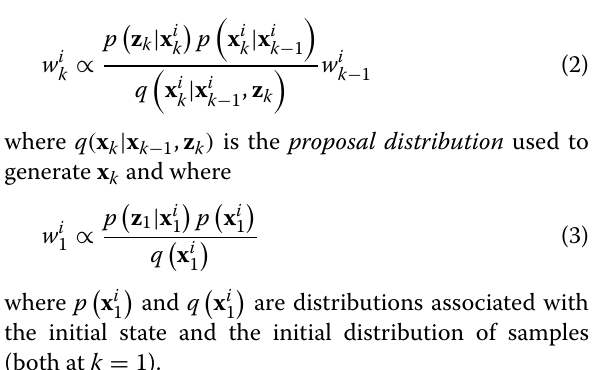
Algorithm 1 SIR Filter—Sequential (Vectorized)